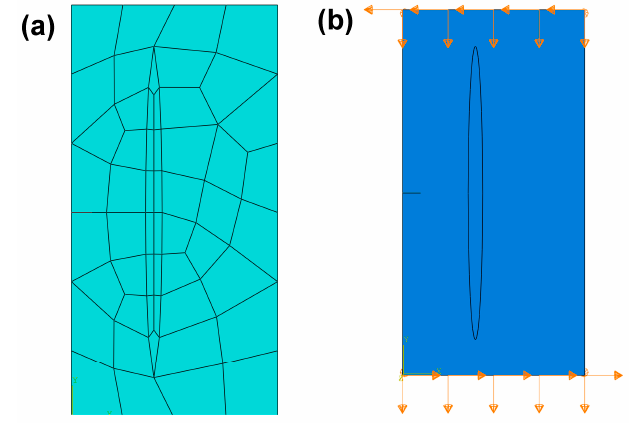
Figure 11. ( a ) Finite element mesh; ( b ) boundary constraint for the composite of SiC fiber-reinforced Ti 3 SiC 2 .